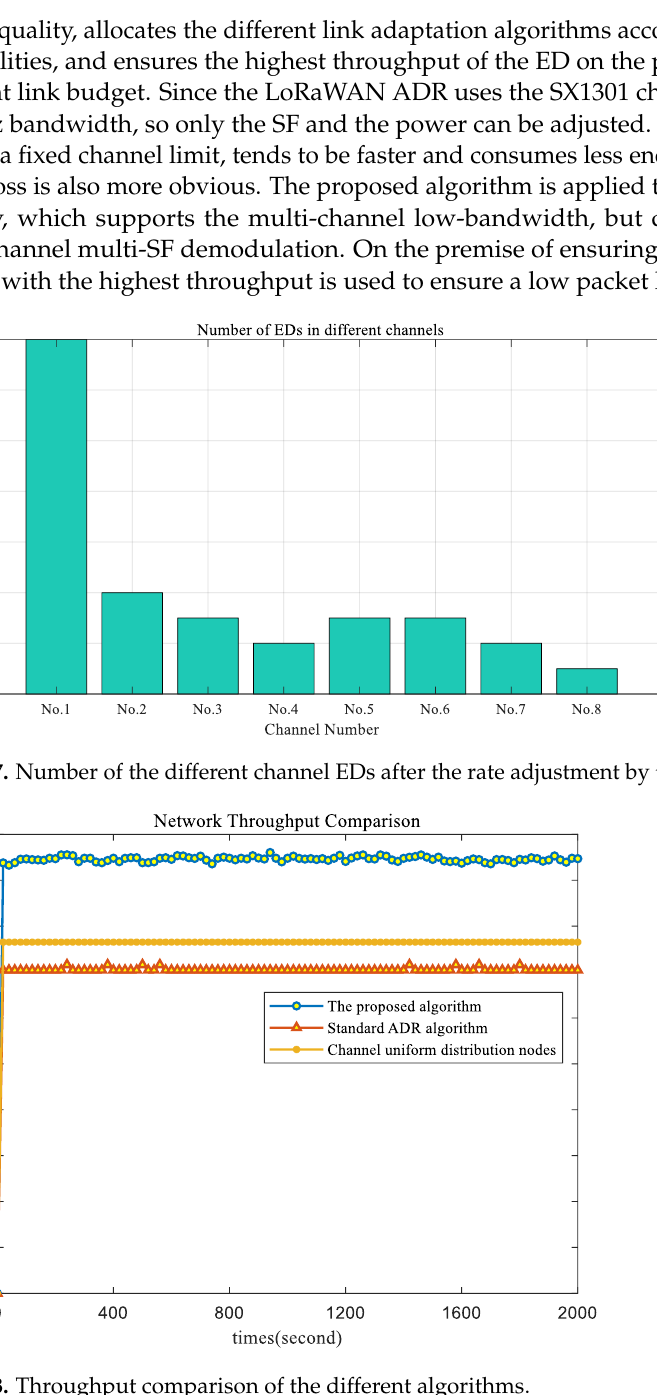
Figure 18. Throughput comparison of the different algorithms.